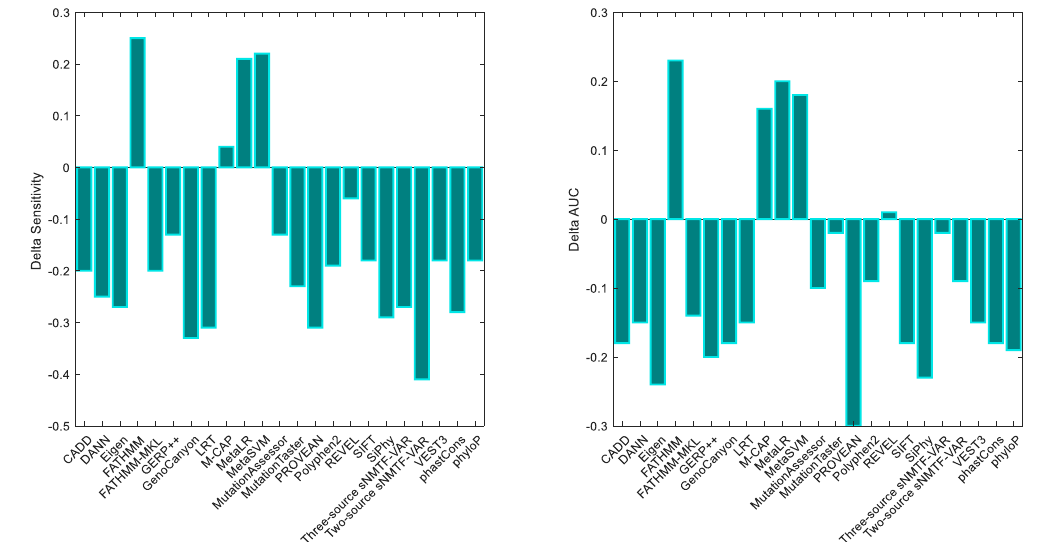
Figure 3. The variation of sensitivity (Right) and AUC (Left) of testing dataset IV in comparison with testing dataset III for different prediction tools and both algorithm of our sNMTF-VAR method. The tools which their bars are over the base line were affected by type 2 circularity error. The figure is created using MATLAB version 7.0.1 (Math Software Co., Math Works,